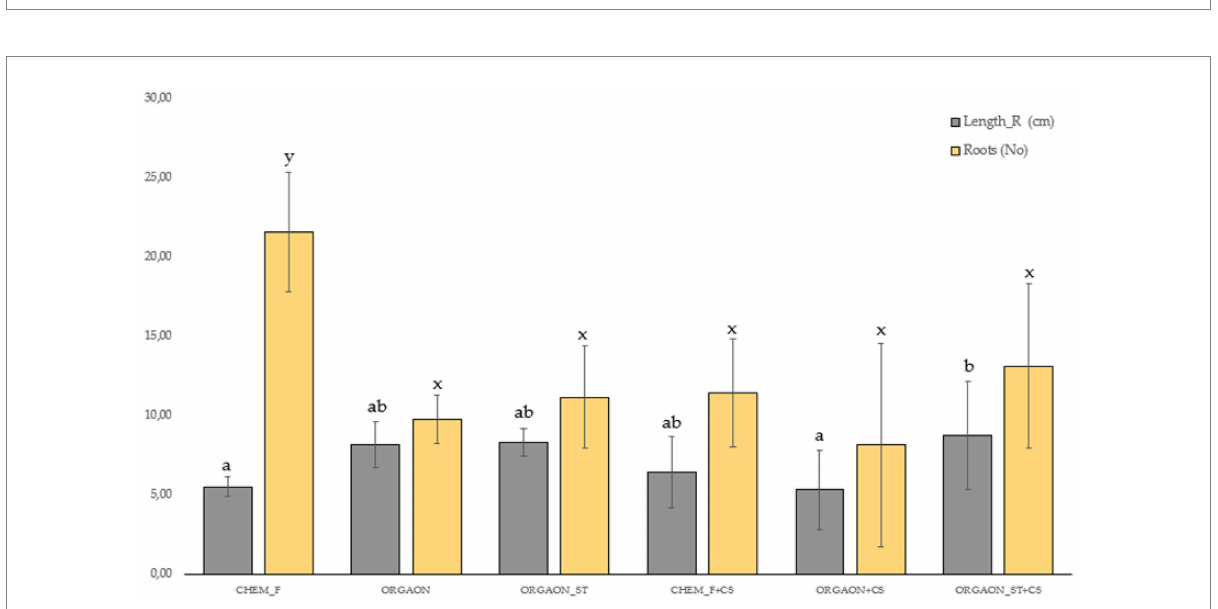
FIGURE 4 Weight biometrics of lupine plants subjected to different irrigation treatments with biofertilizer with both SAICEU11 T and SAICEU22 T (CS). Different letters denote statistically significant differences according to Duncan test ( p < 0.05) for the root length (a, ab, and b) and the number of secondary roots ( x and y ).